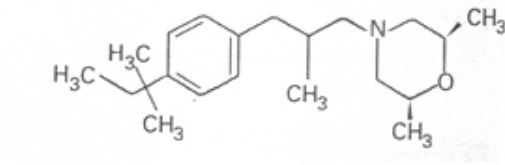
FIGURE 3. The chemical structure of